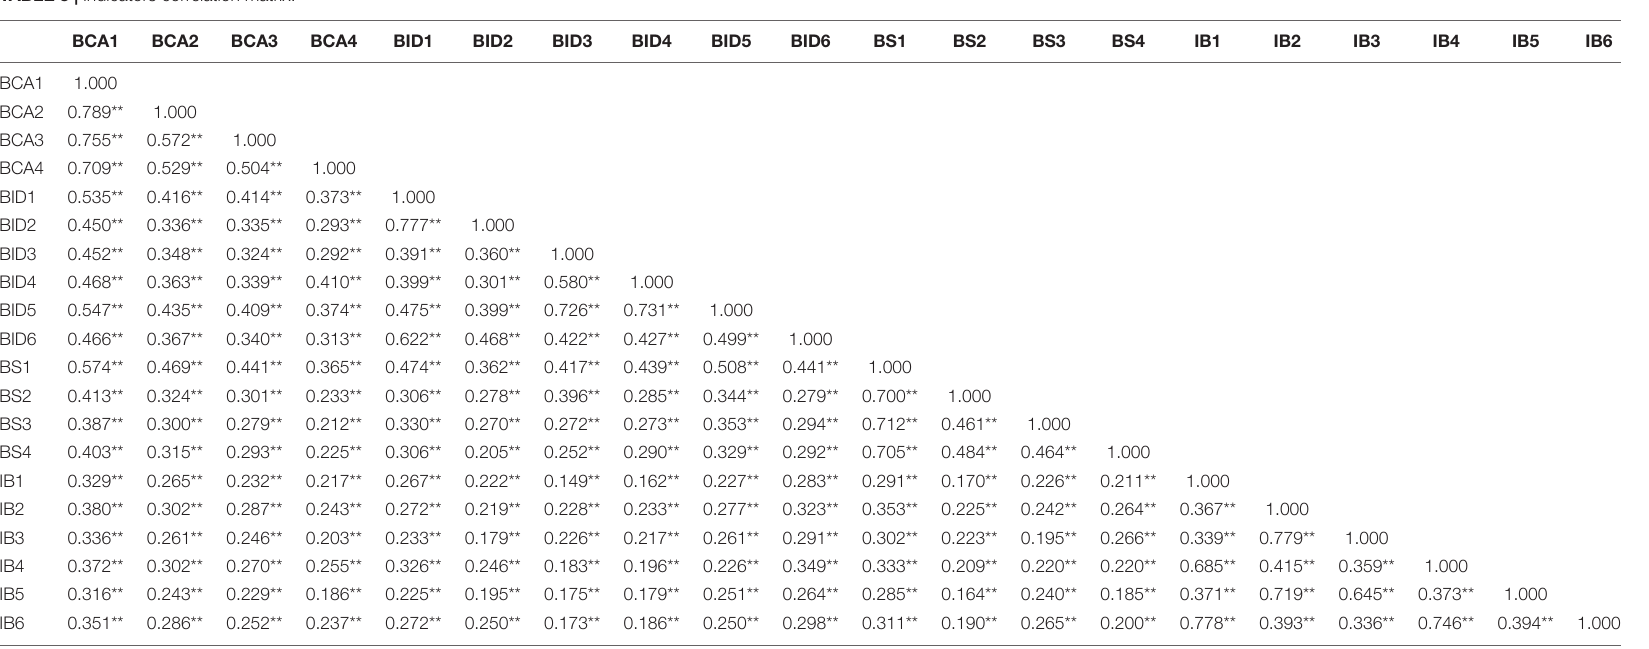
TABLE 3 | Indicators correlation